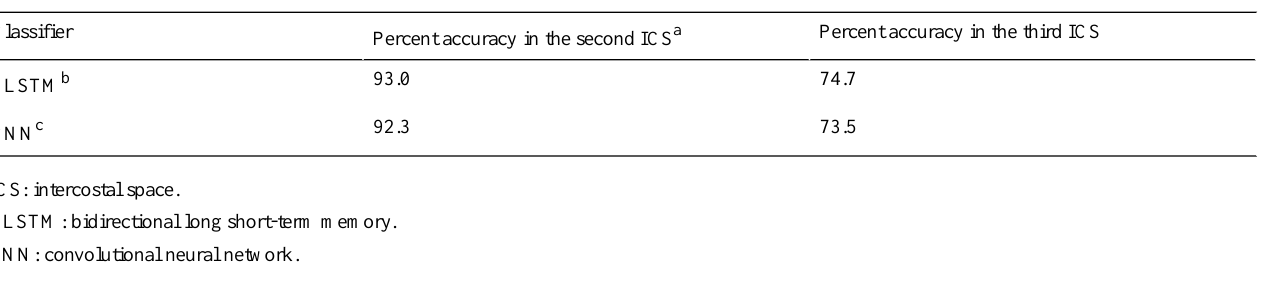
Figure 3. Receiver operating characteristic curves and other metrics results for deep learning and machine learning for detecting electrode misplacement in the second and third intercostal spaces. BLSTM: bidirectional long short-term memory; CNN: convolutional neural network; PNT: predictivity of negative test; PPT: predictivity of positive test.